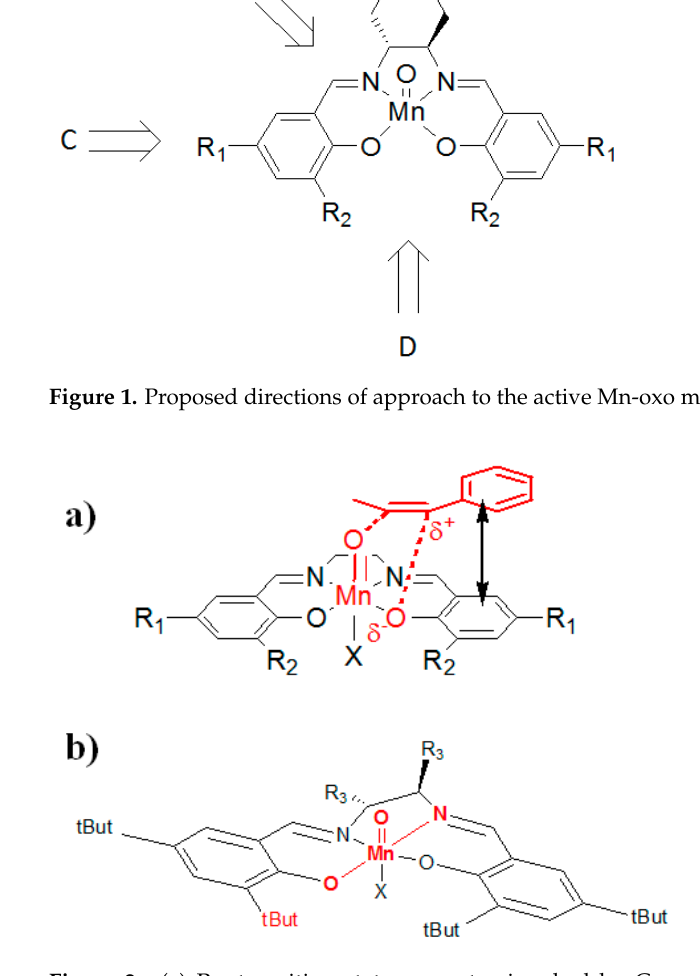
Figure 2. ( a ) Pre-transition state geometry invoked by Corey; ( b ) spatial arrangement of the salen catalyst.